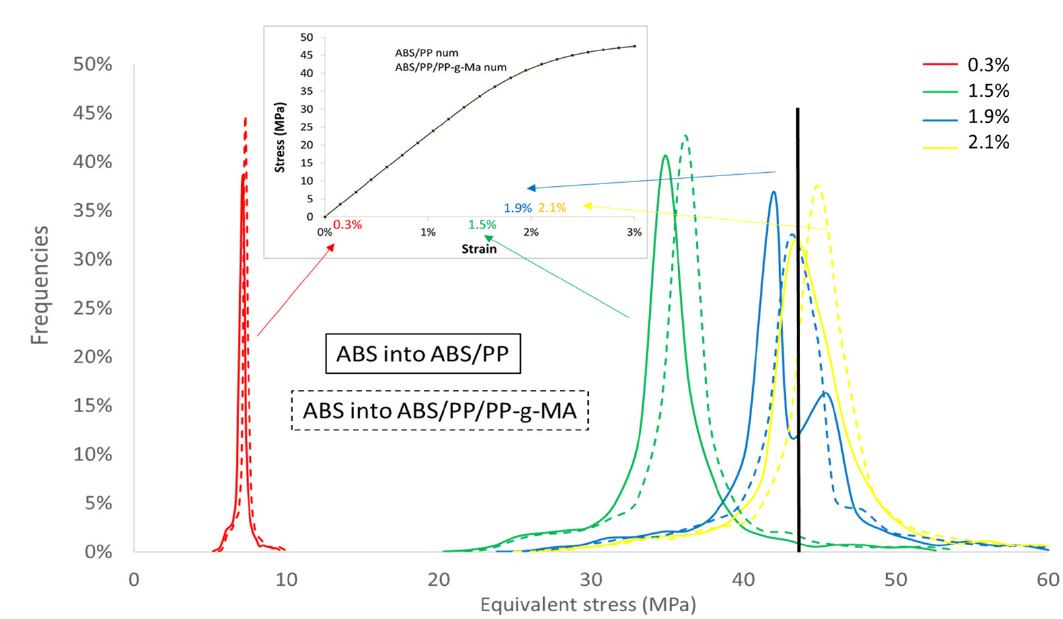
Figure 19. Frequencies of elements versus equivalent stresses for several macroscopic strains for ABS into ABS/PP and ABS/PP/PP-g-MA blends.